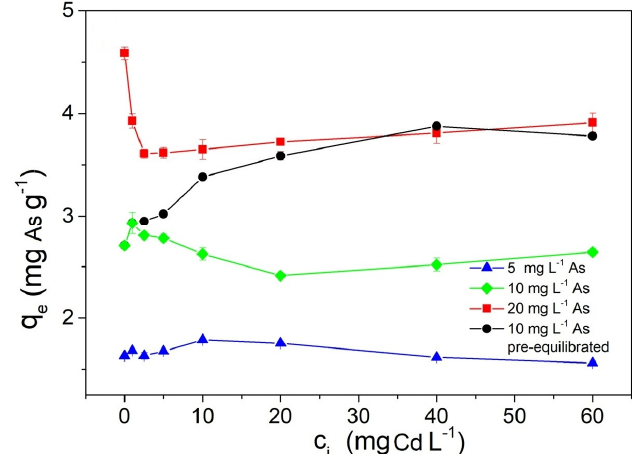
Figure 26. The effect of different initial concentrations of Cd(II) on the adsorption capacity of As(III) [143]. Reprinted with permission from Jizi Wu et al. (2018). Copyright 2018, Elsevier.